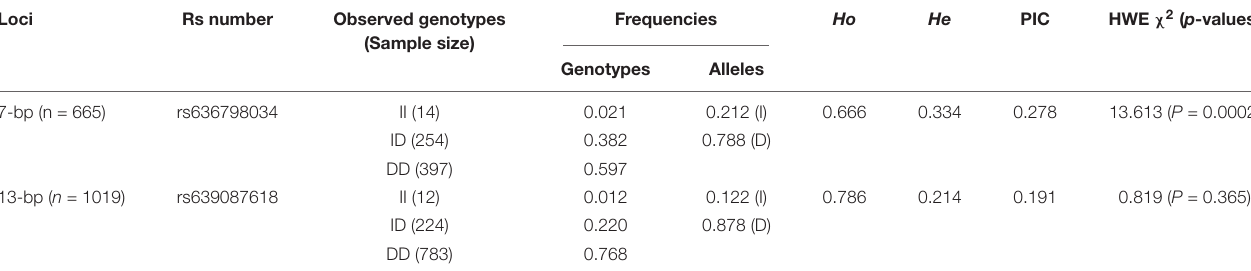
TABLE 2 | Genotype and allele frequency of two indel loci within AKAP12 gene in Shaanbei white cashmere (SBWC) goats. Loci Rs number